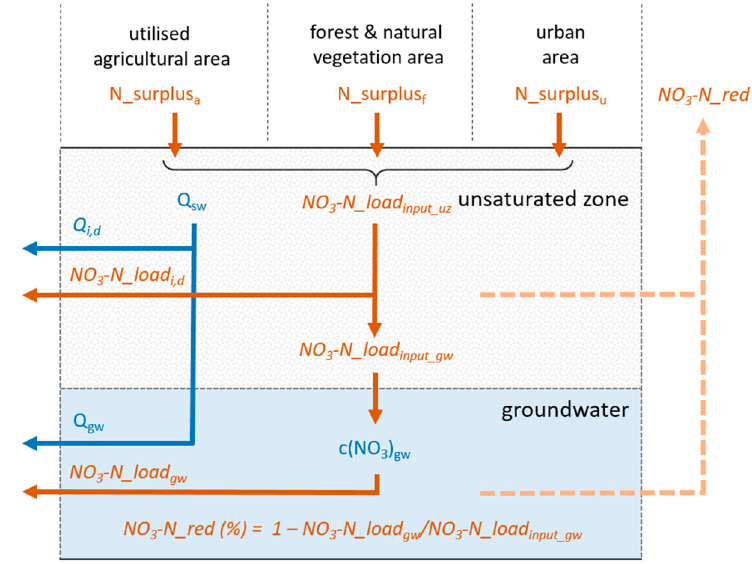
Figure 1. Flow paths and nitrate nitrogen loads (NO 3 -N loads) through the unsaturated zone and the groundwater body with N_surplus a,f,u = hydrospheric N surplus for di ff erent land-use types (a = agriculture (including arable land, grassland and special crops), f = forest, and u = urban) (kg N ha − 1 a − 1 )); Q sw = seepage water (mm a − 1 ); Q gw = groundwater recharge (mm a − 1 ); Q i , d = interflow, drainage (mm a − 1 ); c(NO 3 ) gw = NO 3 concentration in the groundwater (mg l − 1 ); NO 3 − N_load input_uz = NO 3 -N input load in the unsaturated zone (kg N ha − 1 a − 1 ); NO 3 − N_load input_gw = NO 3 -N input load in the groundwater (kg N ha − 1 a − 1 ); NO 3 − N_load gw = groundwater NO 3 -N load (kg N ha − 1 a − 1 ); NO 3 − N_red = nitrate reduction rate (%). Calculated values in italic; blue arrows represents water fluxes and orange arrows represents NO 3 -N_loads.